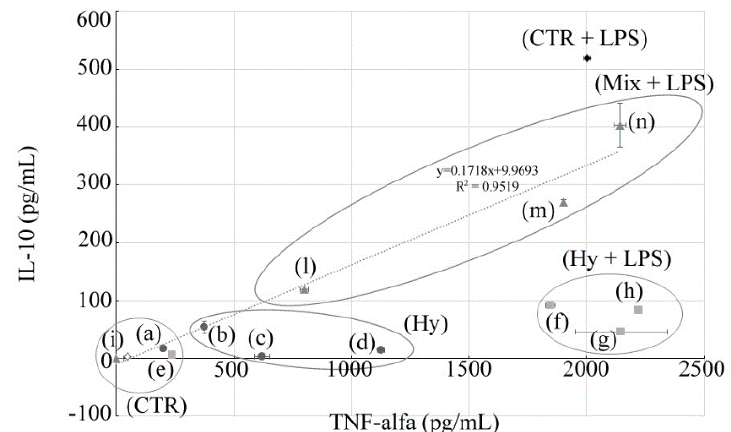
Figure 2. Variation of the amount of cytokines IL-10 and TNF- α in the medium culture of PBMCs treated with scalar dilutions of the V. vinifera cv Italia Hy alone or in combination with EO and / or LPS. The circle-shaped indicators refer to the samples treated with the Hy only; the squares are referred to the samples treated with the Hy plus LPS, while the triangles show the samples treated with Hy plus the EO of C. aurantium var. amara plus LPS. The white rhombus is the untreated control and the black rhombus is the control treated with LPS. Letters a , b , c and d indicate samples treated with scalar dilution of the Hy (50% v / v , 25% v / v , 12.50% v / v and 0.06% v / v respectively). Letters e , f , g and h are referred to samples treated with scalar dilution of the Hy (50% v / v , 25% v / v , 12.50% v / v and 0.06% v / v respectively) and LPS (1 µ gr / mL). Letters i , l , m and n are referred to PBMCs treated with a 1:100 v / v mixture of the Hy, (50% v / v , 25% v / v , 12.50% v / v and 0.06% v / v respectively) and the EO (0.50% v / v , 0.25% v / v , 0.12% v / v and 0.06% v / v respectively) plus